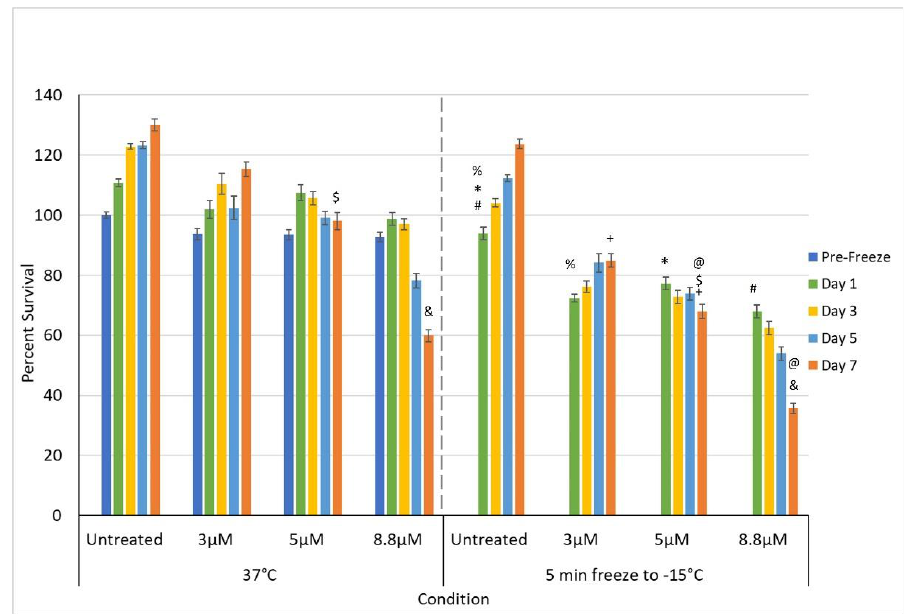
Figure 5. Effect of adjunctive oxaliplatin pretreatment in combination with freezing on PaCa cell survival. Samples were pre-treated with 3, 5, and 8.8 µM oxaliplatin for 48 h and drug removed prior to freezing to −1 5 °C. Sample viability was compared to freezing and oxaliplatin treatment alone. Data reveal a significant improvement in cell death following the combination of 8.8 µM ox- aliplatin and −1 5 °C, whereas 3 and 5 µM oxaliplatin and −1 5 °C samples showed no to minimal benefit (@, #, $, %, &, * = p < 0.01).